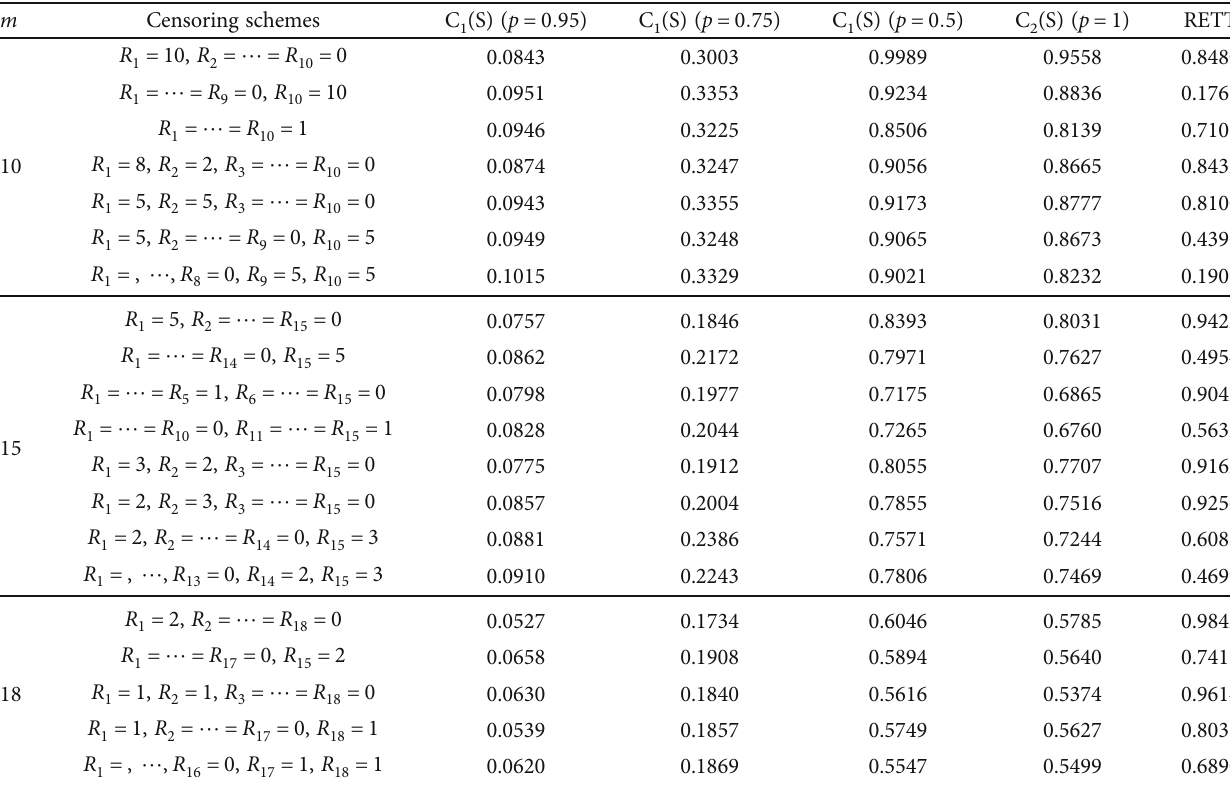
Table 7: Optimum sampling schemes for di ff erent choices of n = 20 and di ff erent choices of m . m Censoring